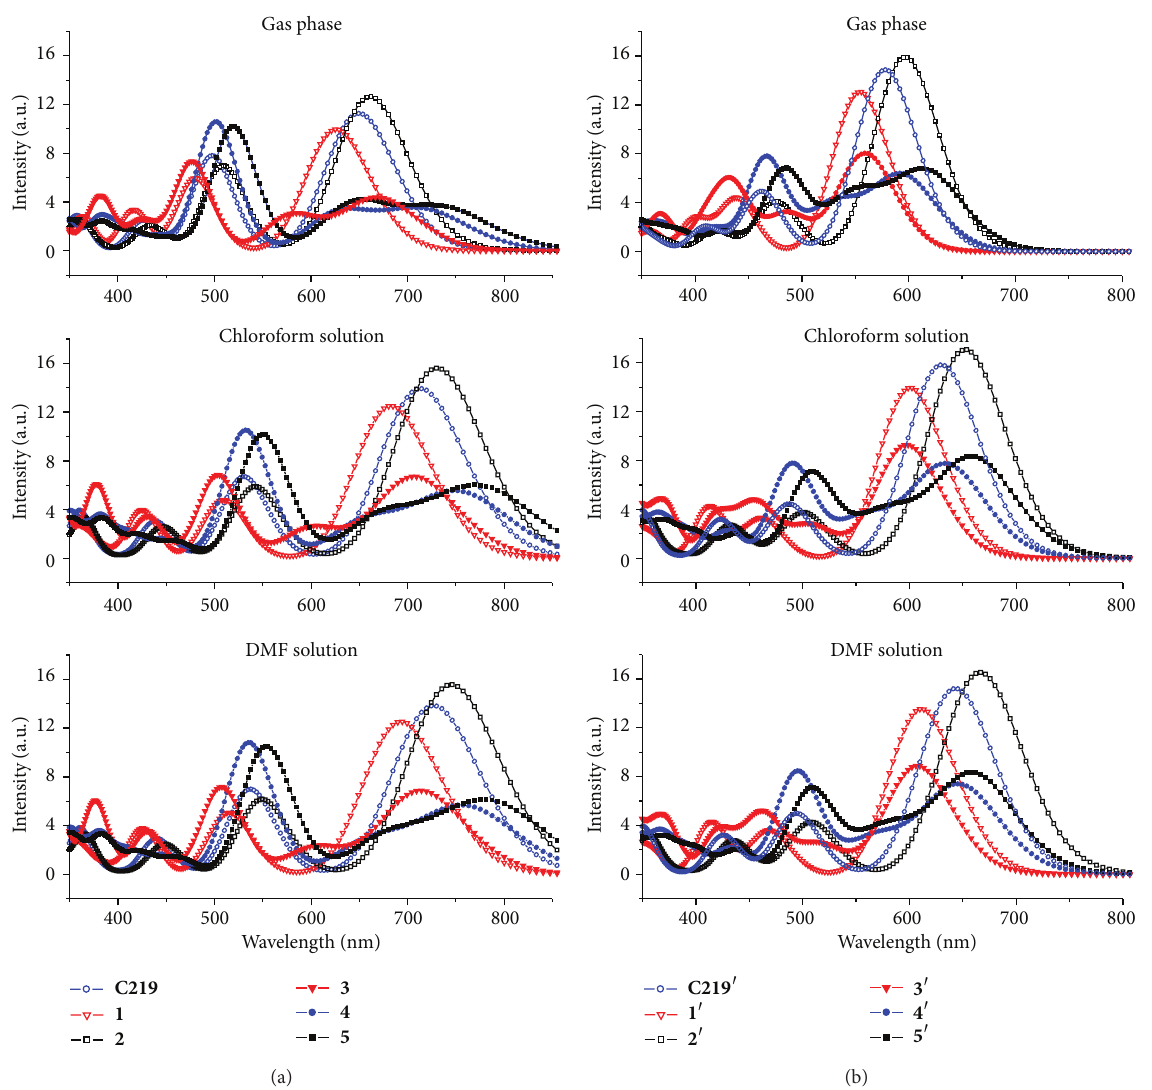
Figure 4: Simulated absorption spectra of H + - (a) and Na + - (b) contained tpa-based